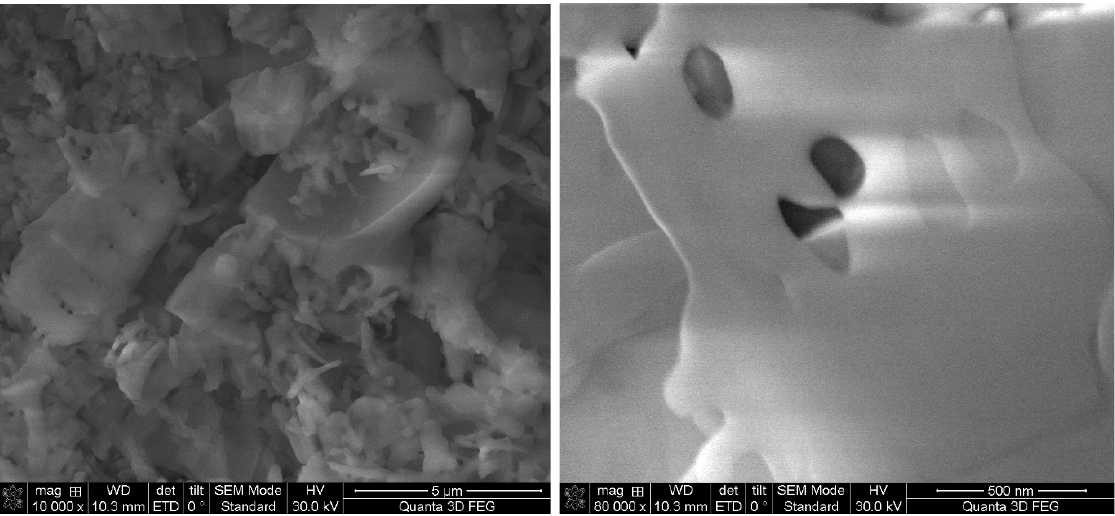
Figure 9: SEM of thermally treated